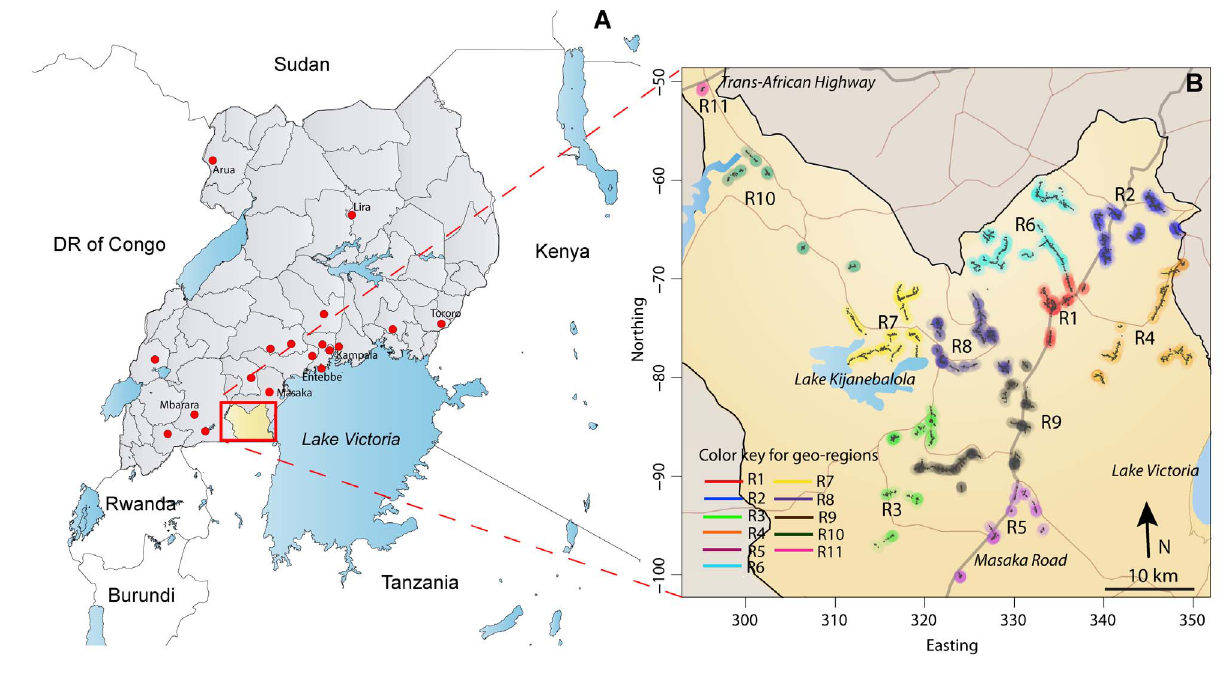
Figure 1. Rakai District, Uganda. (A) Rakai ( , 2,200 km 2 ), a rural district in southwest Uganda, with population , 450,000 ( , 700 communities). RCCS R13 study participants ( n =1,085) reported 1,169 sexual partners with primary residence outside the Rakai District, but within Uganda (where disclosed, residential locations of sexual partners are indicated with red dots on the map). Only three sexual partners were reported to be living outside Uganda (two in Tanzania and one in the United Kingdom, not shown). (B) The Rakai district at a higher resolution, with the 11 geographic regions surveyed in RCCS R13 indicated in color. There are two primary highways (Masaka Road to Tanzania and the Trans-African National Highway to Rwanda and the Democratic Republic of the Congo [DR of Congo]) and numerous secondary roads that extend throughout the district.